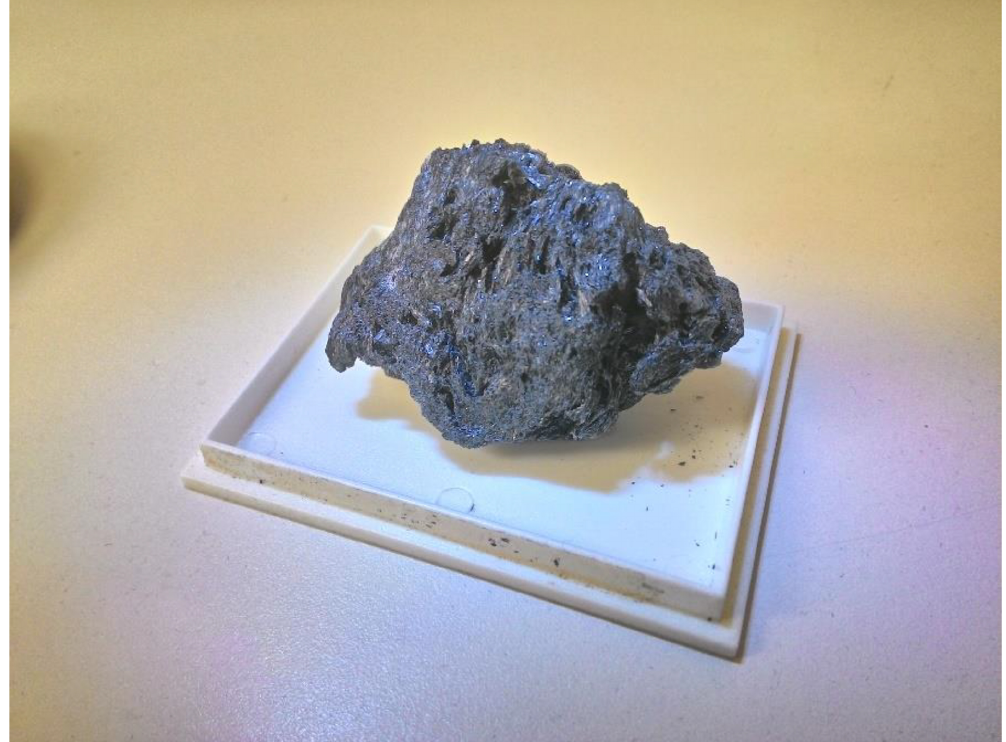
Figure A1. Hand sample as collected in the Chiavolino hamlet (Italy) before any manipulation. The size of the sample is about 5 ×